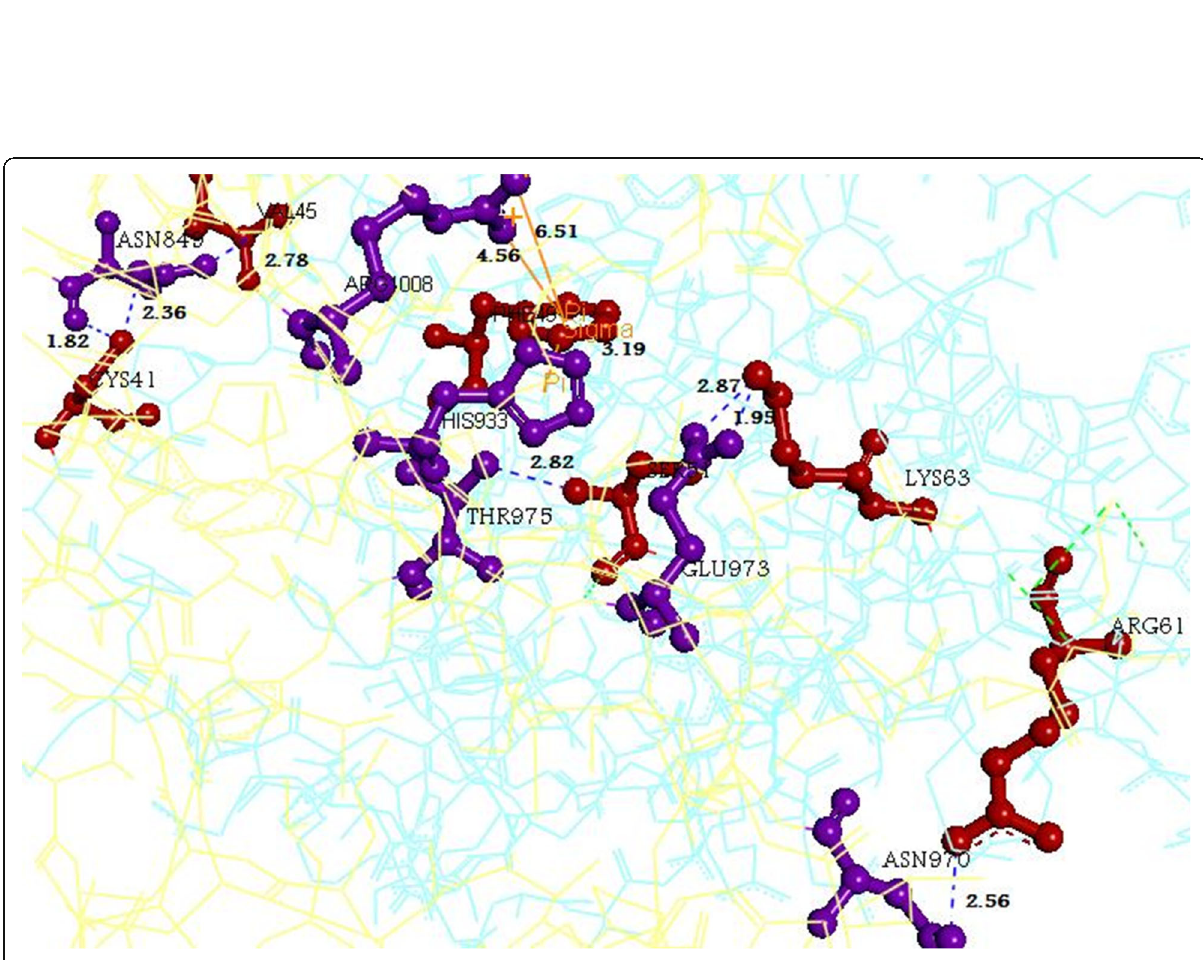
Fig. 9 The protein – protein interaction between Rab39a and natural substrate [25]: The Rab39a (yellow) interacts with DENND5B (green). The specific binding residues of Rab39a are shown in red-labeled sticks (CYS41, VAL45, PHE49, SER51, ARG61 and LYS63) in Rab39a. The residues of DENND5B are represented in violet color, while the H-bond interactions in blue color and π interactions in orange